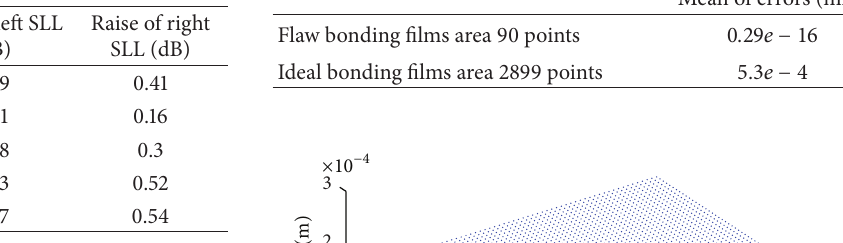
Table 4: Influence of flaw’s dimension on the far field pattern (At node 4).